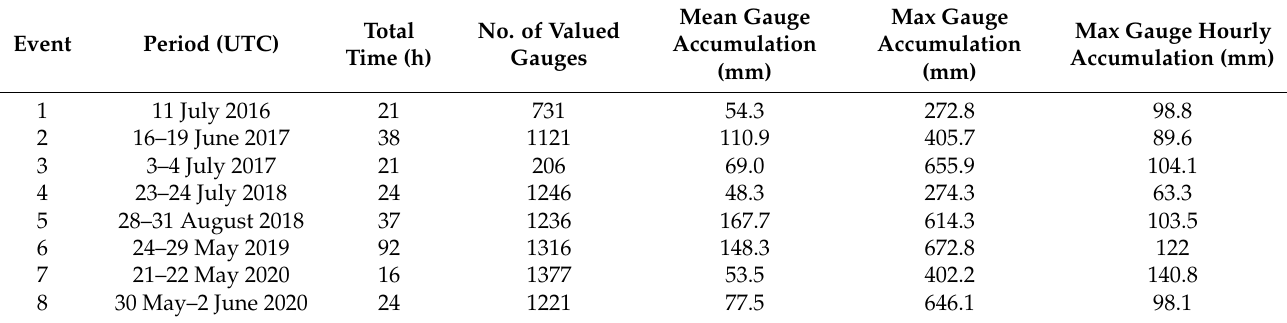
Table 1. A list of the eight monsoon rainfall events analyzed in this